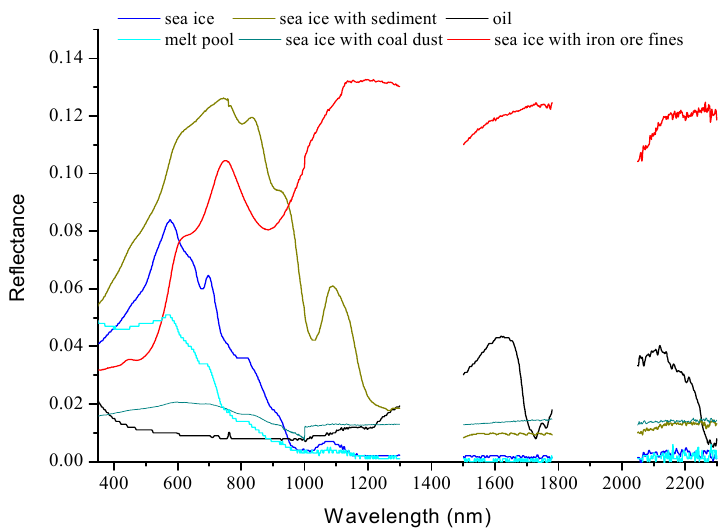
Figure 7. Reflectance spectra of ice with sediments, coal dust, iron ore fines, and that of melt pool.